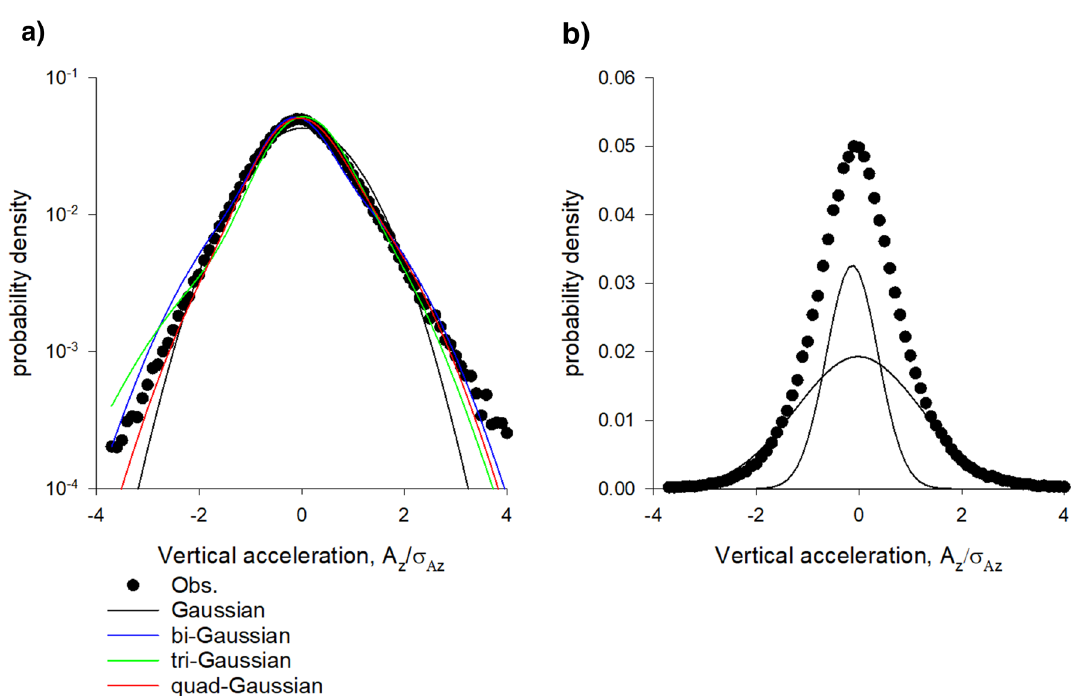
Figure 6. ( a ). Distributions of vertical accelerations are accurately represented by superpositions of Gaussians. ( b ) Constituent Gaussians in the tri-Gaussian representation with centres at •. The Akaike weights for the single-, bi-, tri- and quad-Gaussian fits are 0.05, 0.79, 0.14 and 0.02 indicating strong support for the bi-Gaussian representation. Data are taken from Sinhuber et al. 14 : swarm Ob5 which contains on average 22